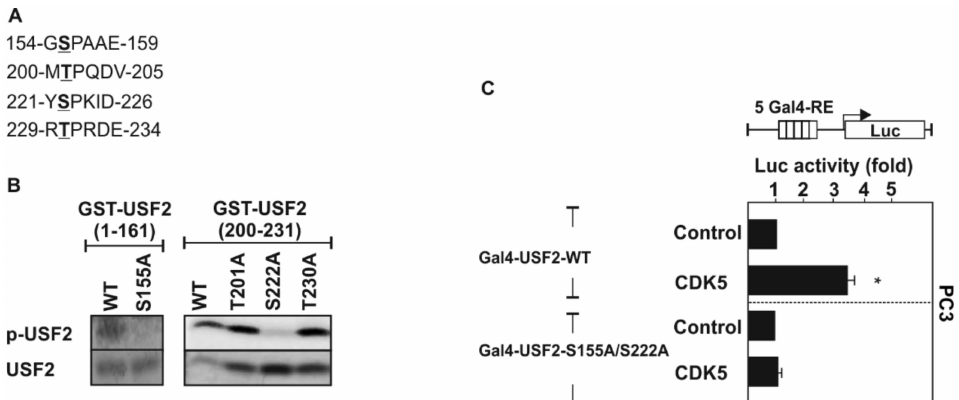
Figure 2. USF2 is phosphorylated at Ser155 and Ser222 by CDK5. ( A ) In silico predicted CDK5 phosphorylation sites in human USF2 ( B ) Purified GST-tagged USF2 variants with point mutations at the predicted CDK5 phosphorylation sites were phosphorylated with recombinant human CDK5 in the presence of [32P]- γ -ATP for 20 min at 30 ◦ C. Proteins were separated by 10% SDS-PAGE and radioactivity was detected by autoradiography. The lower panel shows the recombinant USF2 proteins on a Coomassie-stained gel performed as a loading control. ( C ) PC3 cells were cotransfected with pFR-5Gal4-RE-Luc, an expression vector for CDK5 and constructs expressing WT or mutant pcDNA6-Gal4-USF2 (1–231) or the appropriate empty Gal4 vector. The luciferase activity was calculated as fold induction compared to the Gal4-USF2 (1–231)-WT luciferase activity after subtracting the values from the empty Gal4 expression vector. *, significant di ff erences control vs.